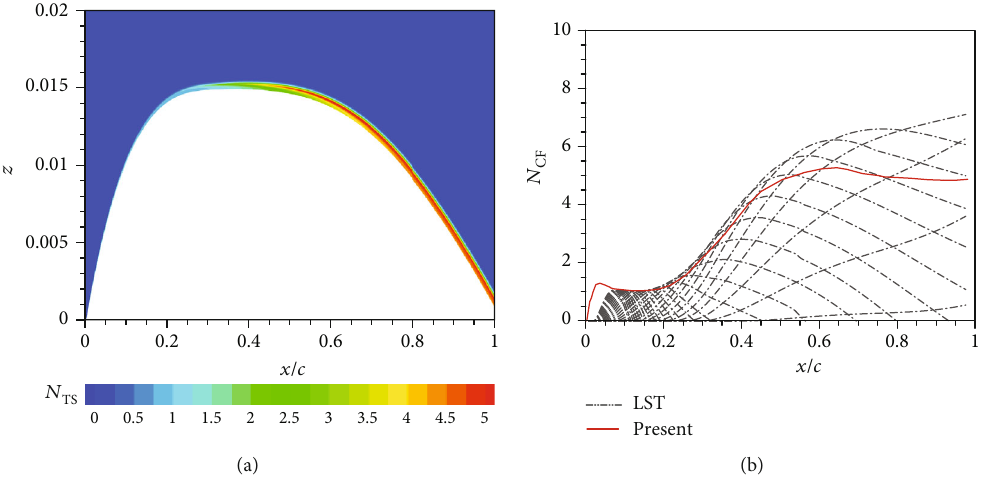
Figure 15: The predicted (a) N contour and (b) comparison with standard LST analysis results at Re = 3 : 5 × 10 7 /m TS